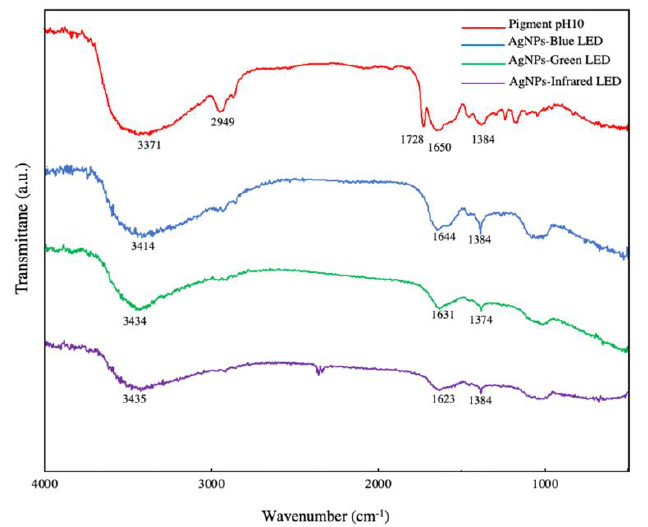
Table 3. Frequency range obtained by FTIR and the corresponding functional groups.